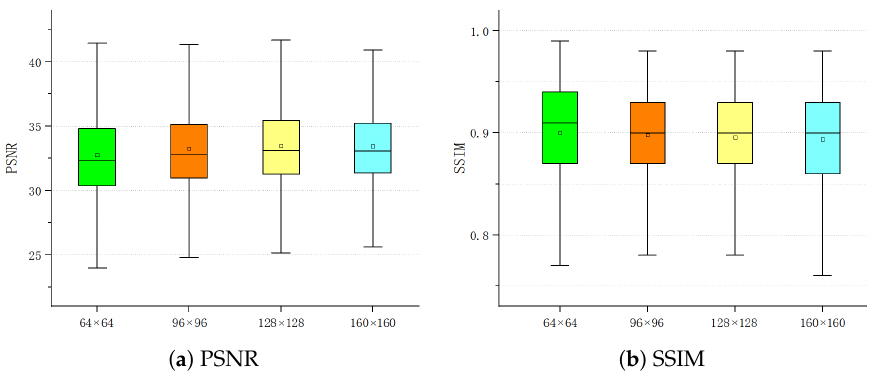
Figure 10. The distribution of PSNR and SSIM of Ref-MFFDN when dealing with input images at different scales. The box plot displays the maximum, upper quartile, median, lower quartile, and minimum of results from top to bottom. The rectangle inside the box represents the average metrics of results.